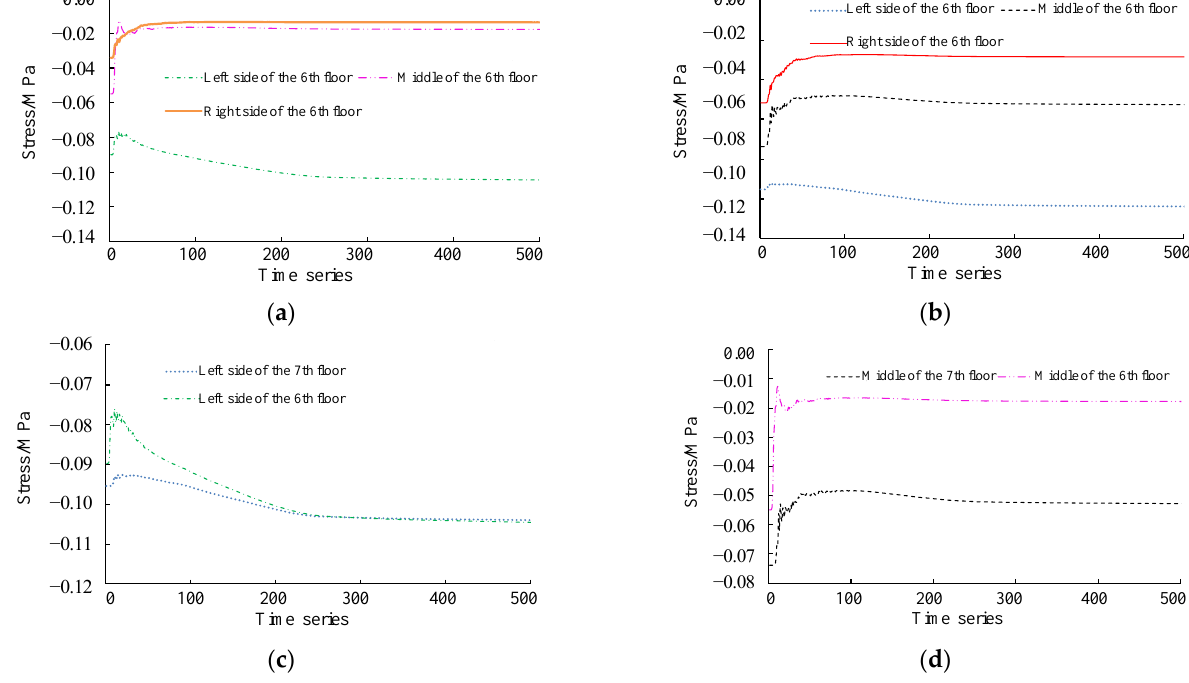
Figure 9. Static load vertical stress of bottom plate after excavation of the sixth layer. ( a ) 6th layer; ( b ) 7th layer; ( c ) Left side of roadway floor; ( d ) Middle of roadway floor.